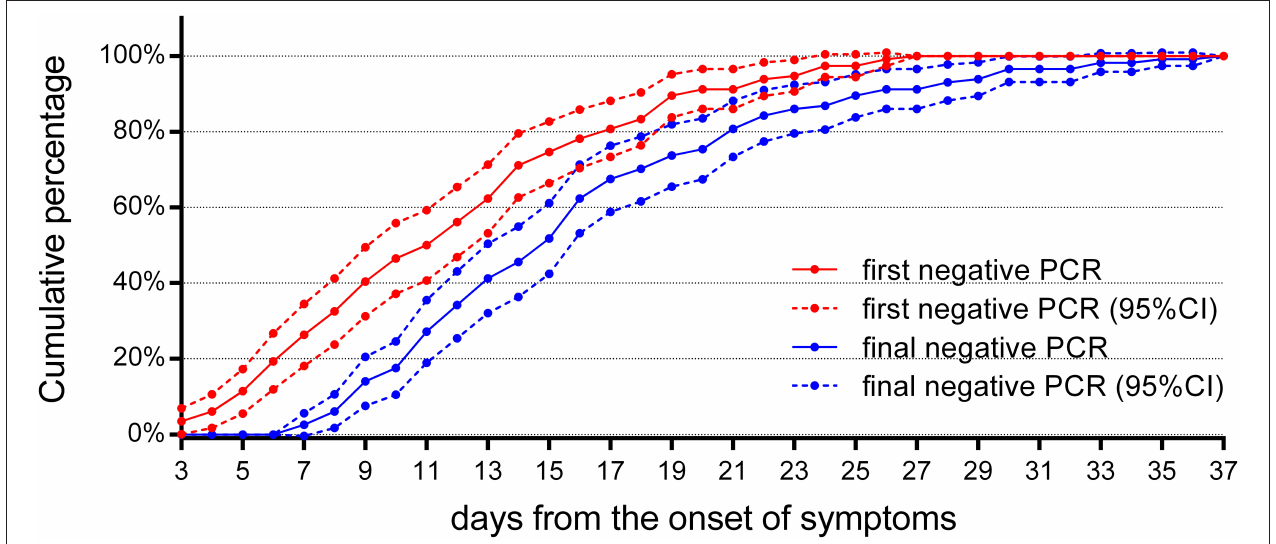
FIGURE 6 | The cumulative percentages of the follow-up RT-PCR. The cumulative percentages of the first and the final negative results of follow-up RT-PCR ( n = 114). The first negative RT-PCR results could be obtained as early as 3 days from the onset of symptoms in four cases, but they returned to positive later. A reliable